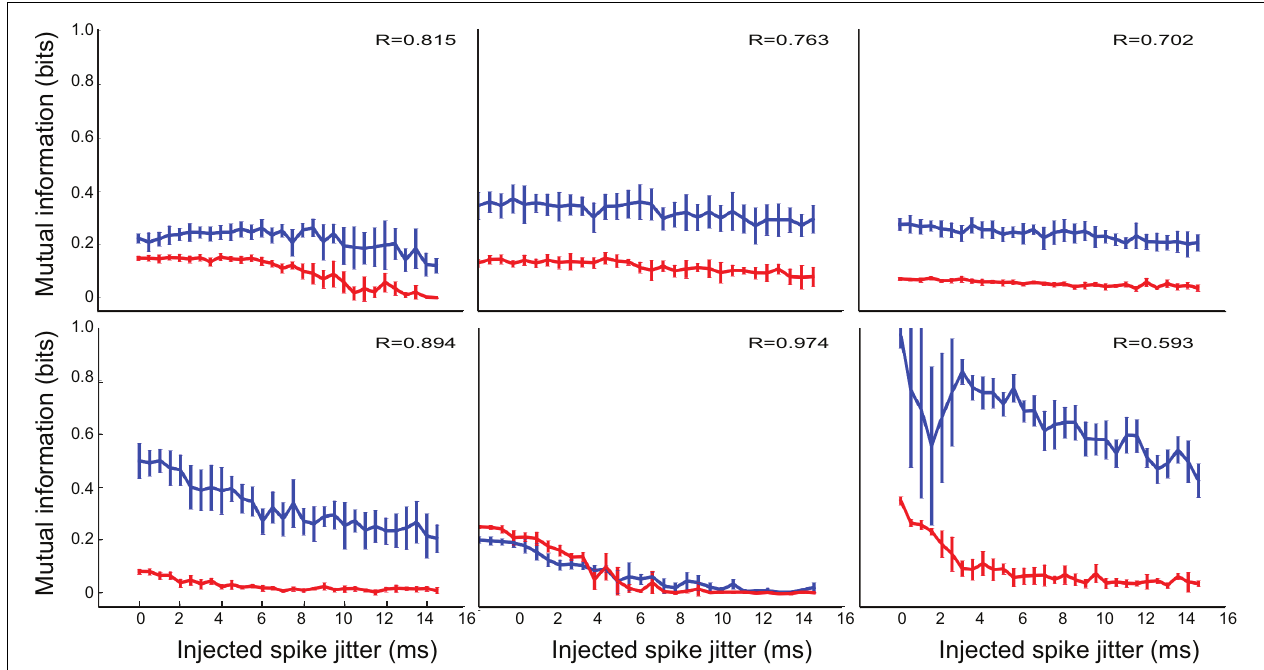
FIGURE 6 | Temporal precision for modified neurons, as measured by the mutual information in bits per spike (bps) of perturbed spike trains, exhibited the same trend. However, in contrast to the situation in Figure 5 ,